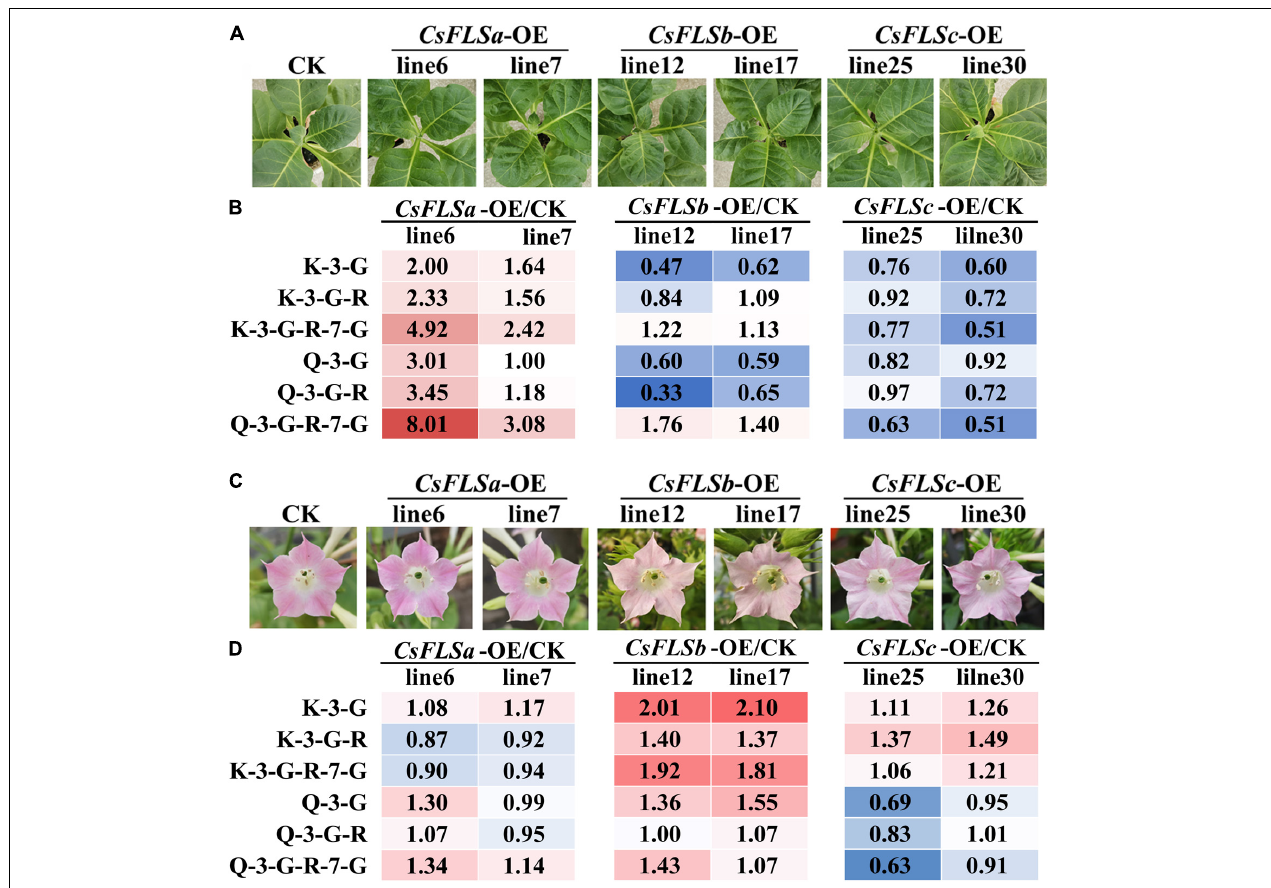
FIGURE 5 | Flavonol accumulation characteristics in CsFLS s transgenic tobacco leaf and flower. (A) Phenotypes of CK and CsFLSa , CsFLSb , and CsFLSc transgenic tobacco leaves. (B) Relative accumulation of kaempferol and quercetin glycoside extracts from CK and CsFLS s tobacco leaves. (C) Phenotypes of CK and CsFLSa , CsFLSb , and CsFLSc tobacco flowers. (D) Relative accumulation of kaempferol and quercetin glycosides of CK and CsFLS s tobacco flowers. CK, empty vector